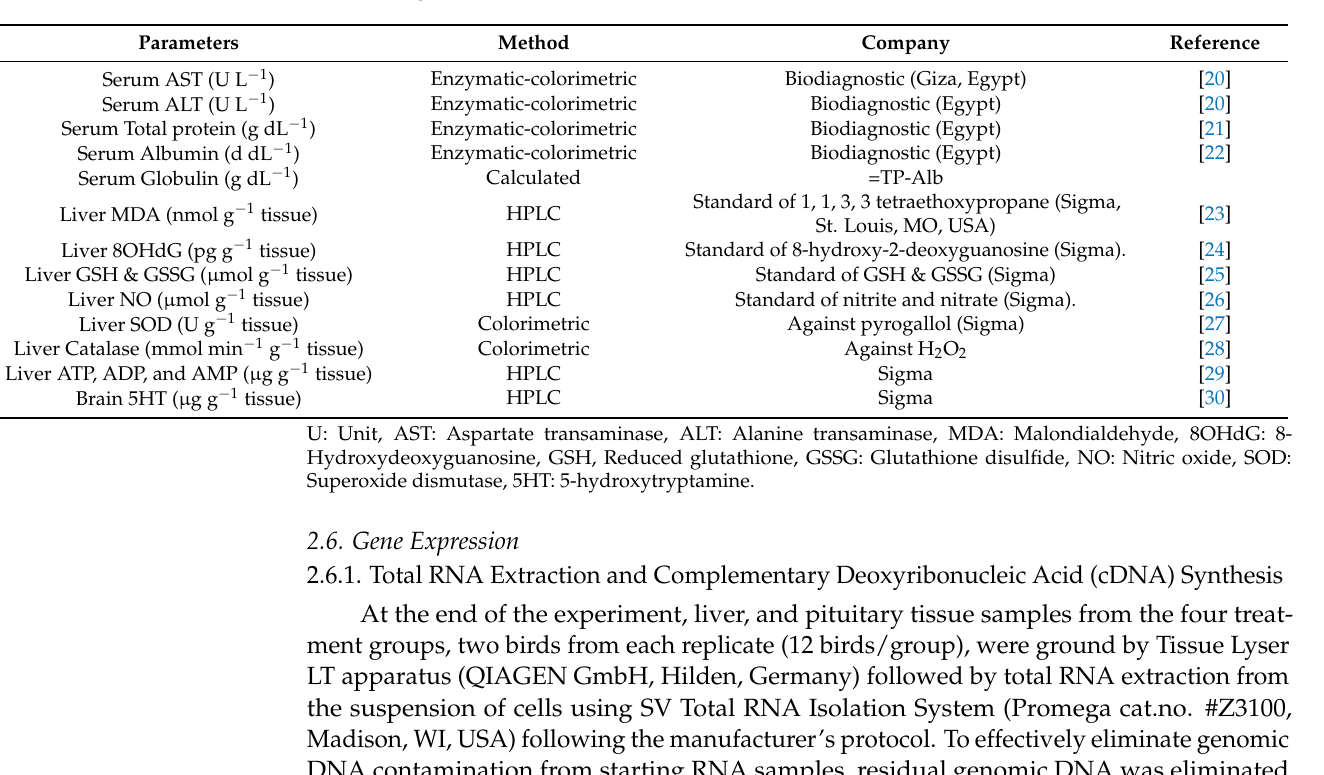
Table 3. Methods and kits used to quantify the different biochemical analyses of blood and liver